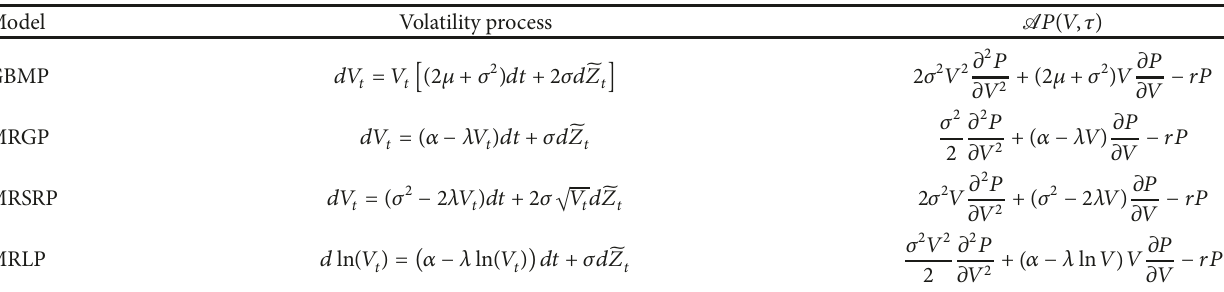
Table 1: Volatility models and infinitesimal generators.